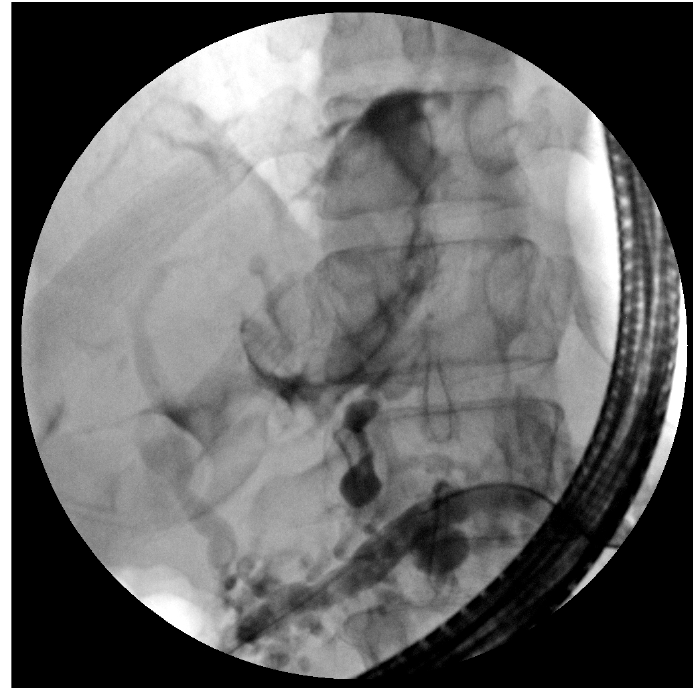
Figure 4. Pancreaticopericardial fistula coursing cranially surrounded a circular sac, consistent with the pericardium.